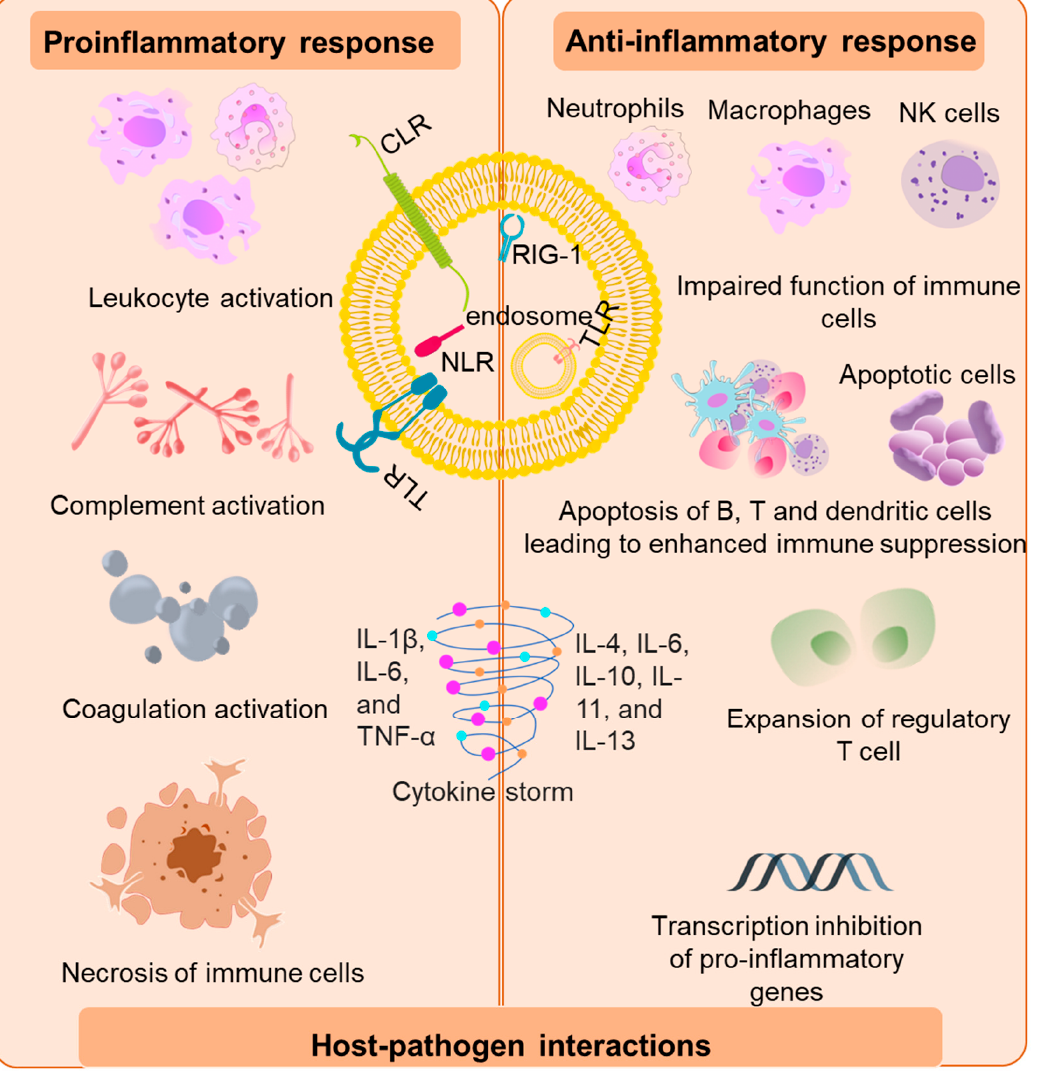
Figure 1. Immunopathogenesis of sepsis. The initial host response is triggered by the binding of bacterial virulence factors to the various pattern recognition receptors such as toll-like receptors (TLR), C-type lectin receptors (CLRs), nucleotide-binding oligomerization domain (Nod)-like receptors and retenoic-inducible gene I (RIG-I). The pro-inflammatory response is marked by the activation of leukocytes which further activates components of the complement and coagulation systems and vascular endothelium via secretion of mediators such as cytokines, reactive oxygen species, and proteases. This led to release of damaged associated molecular patterns (DAMPs) that further exac- erbate the pro-inflammatory response. The anti-inflammatory response is represented by impaired function of immune cells, abnormal level of apoptosis, exhaustion of B cells, T cells, and dendritic cells due to negative regulation of TLR signaling and inhibition of pro-inflammatory genes leading to “immunoparalysis”.